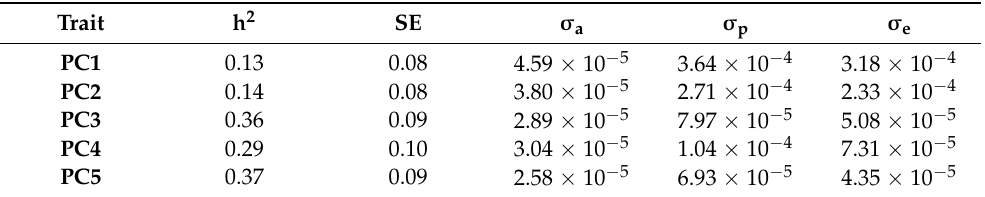
Table 7. Heritabilities with corresponding standard errors, additive genetic ( σ a ), phenotypic ( σ p ) and residual ( σ e ) variances of the first five relative warp scores (PC1–PC5).